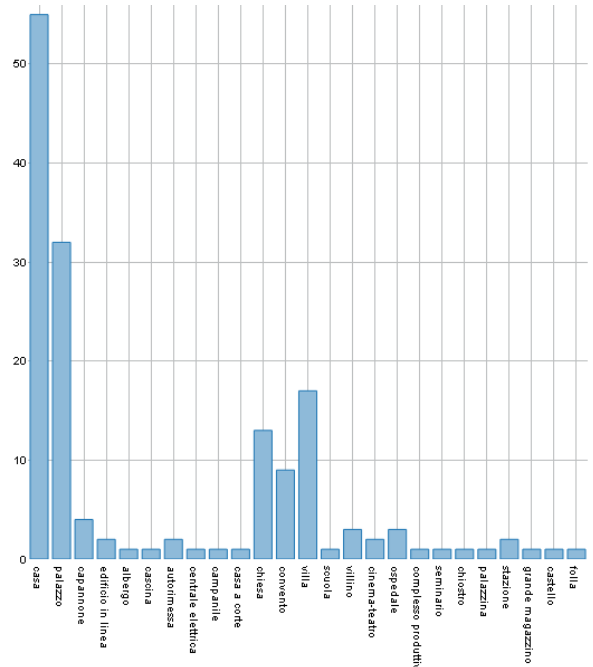
Figure 5. Histogram of typologies of cultural heritage in historical centre of Monza made with plug-in DataPlotly. Low- quality resolution and not presented numerical values are the main shortcomings of this approach (source: D. Jovanović).